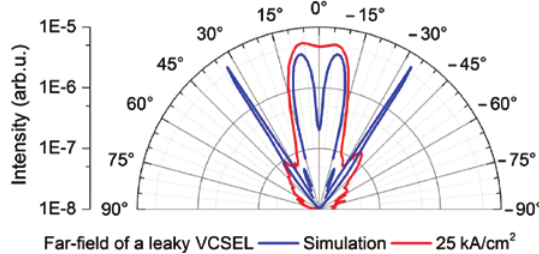
Figure 8: Far-field profile of a leaky VCSEL (simulation and measurement).